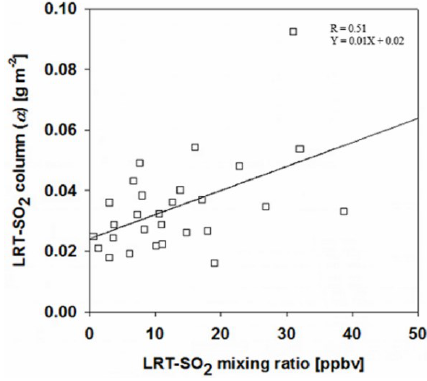
Figure 4. Correlations between LRT-SO 2 column ( α ) and LRT-surface SO 2 mixing ratio.